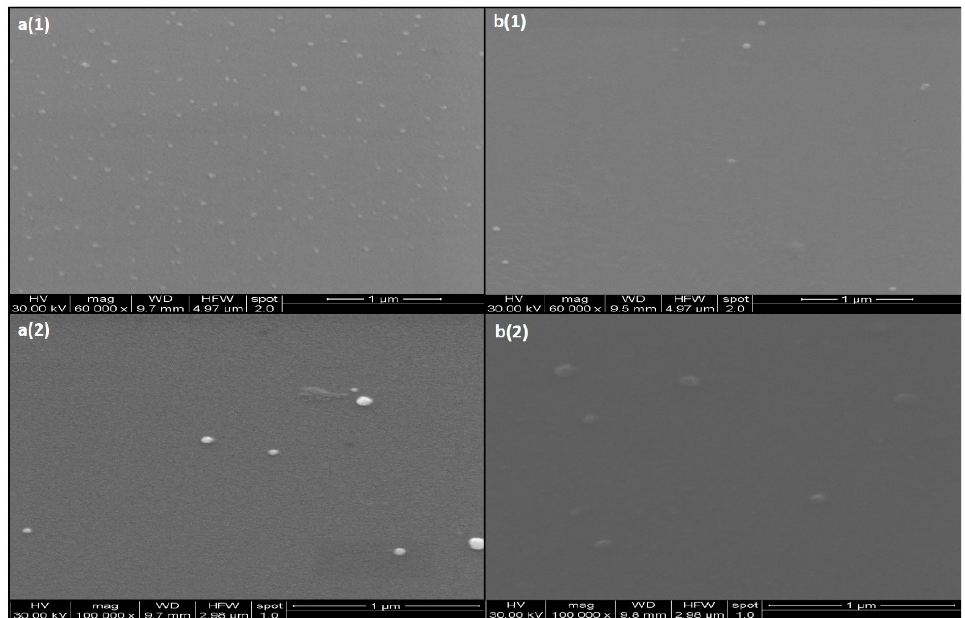
Figure 4. Scanning electron images of ( a1 , a2 ) GNPs at different magnifications and ( b1 , b2 ) CGNPs at different magnifications.